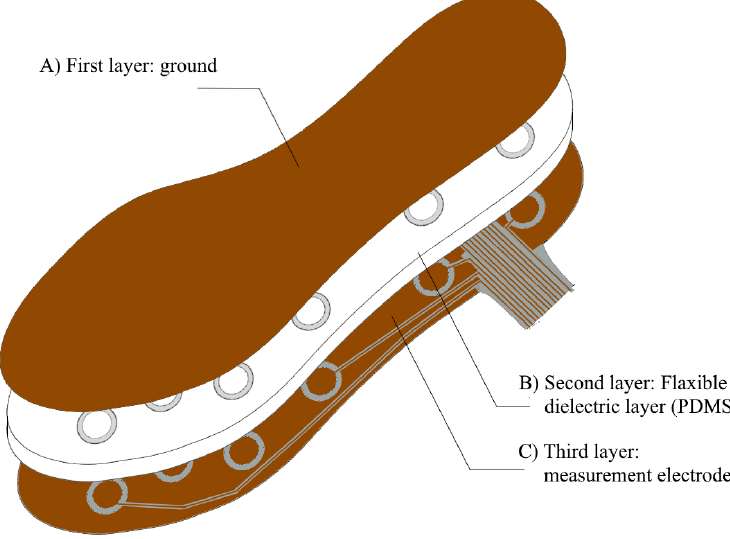
Figure 1. Scheme of main layers that make up the proposed plantar